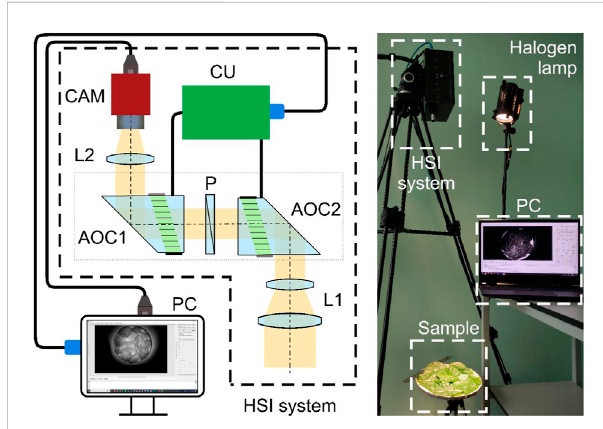
FIGURE 2 Scheme (left)and appearance (right) of theexperimentalsetup. It consists of the light source (LS) for sample illumination, AOTF-based HSI system for data acquisition and PC for data processing and storage. HSI system includes two acousto-optical crystals AOC1 and AOC2 with polarizer P located between them, optical couplers L1 and L2, AOTF control unit CU and monochrome camera CAM.